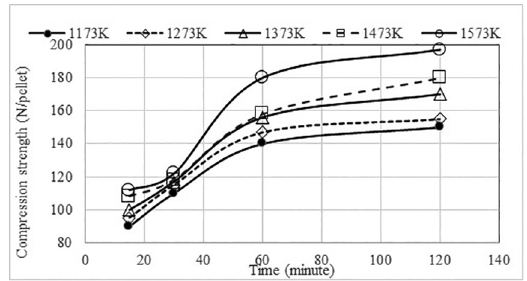
Figure 4: Influence of time and temperature on the strength of pellet P7 (4% sodium silicate).